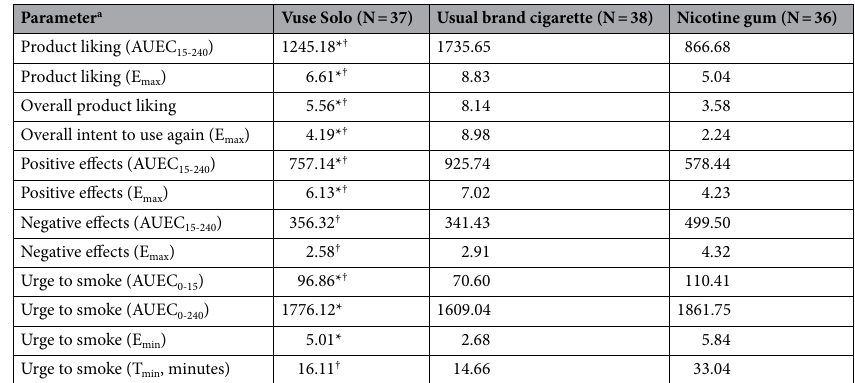
Table 1. Statistical comparisons of subjective measures parameters between Vuse Solo and the high- and low-AL comparators. The high- and low-AL comparators were not compared to each other. AUEC 15–240 area under the effect curve from 15 to 240 min after the start of product use, E max maximum effect score, AUEC 0–15 area under the effect curve from 0 to 15 min after the start of product use, AUEC 0–240 area under the effect curve from 0 to 240 min after the start of product use, E min minimum effect score, T min time to minimum urge to smoke. a Least squares means from mixed-effect models are presented. *Significantly different from usual brand cigarette; p < 0.05. † Significantly different from nicotine gum; p <